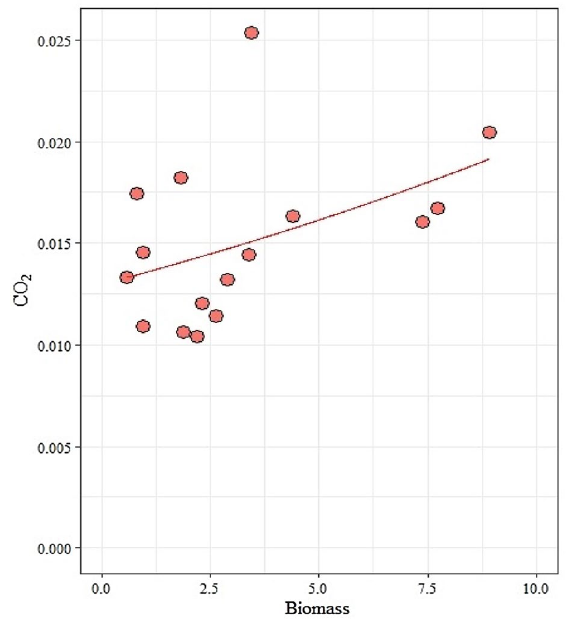
Figure 1. Relation between CO 2 production and biomass of early colonies of Atta sexdens (Hymenoptera: Formicidae) in soil.